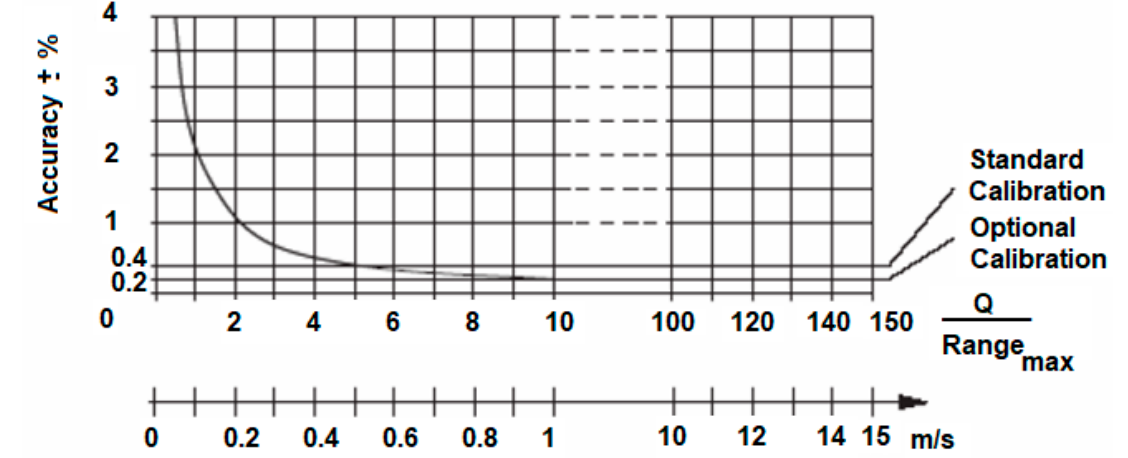
Figure 2. Electromagnetic flowmeter accuracy curve [1].